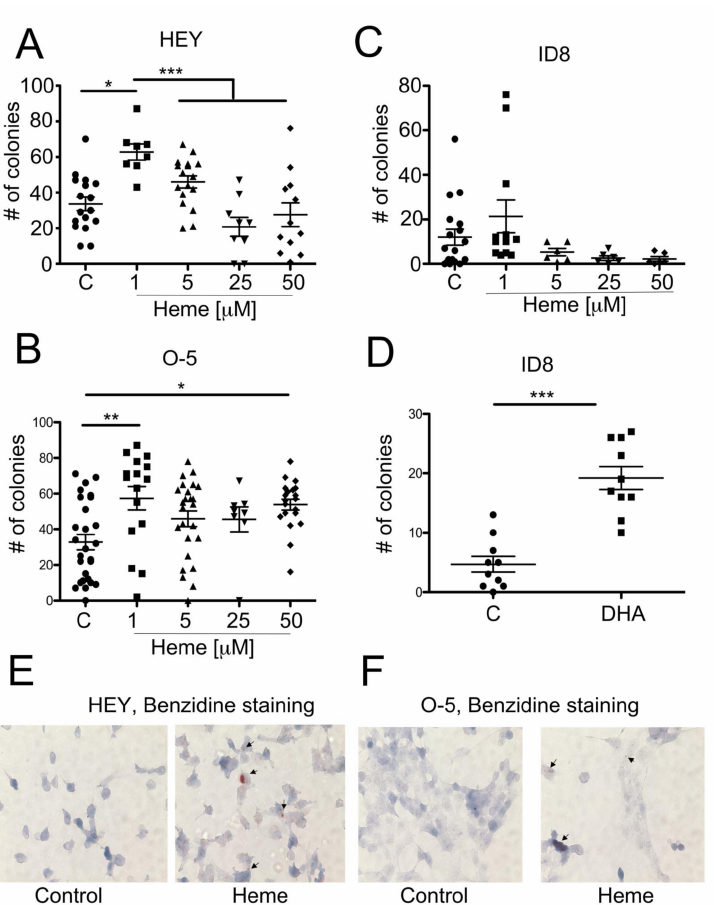
Figure 4. Heme accumulation in cancer cells is associated with anchorage-independent growth. ( A – C ) Anchorage-independent growth in soft agar of HEY and OVAR-5 (O-5) and ID-8 ovarian cancer cells treated with heme (1–50 µ M) was assessed at 3 weeks. * p < 0.05, ** p < 0.01, *** p < 0.001. Data are representative for n = 4–5 experiments in duplicates or triplicates. ( D ) ID8 cells were treated with DHA, an inhibitor of ALA synthetase and colony growth was evaluated at 3 weeks. *** p < 0.001. Data are representative for n = 6. ( E , F ) The heme levels were measured by the benzidine staining in HEY and OVAR-5 cells treated with heme for 24 h. Magnification